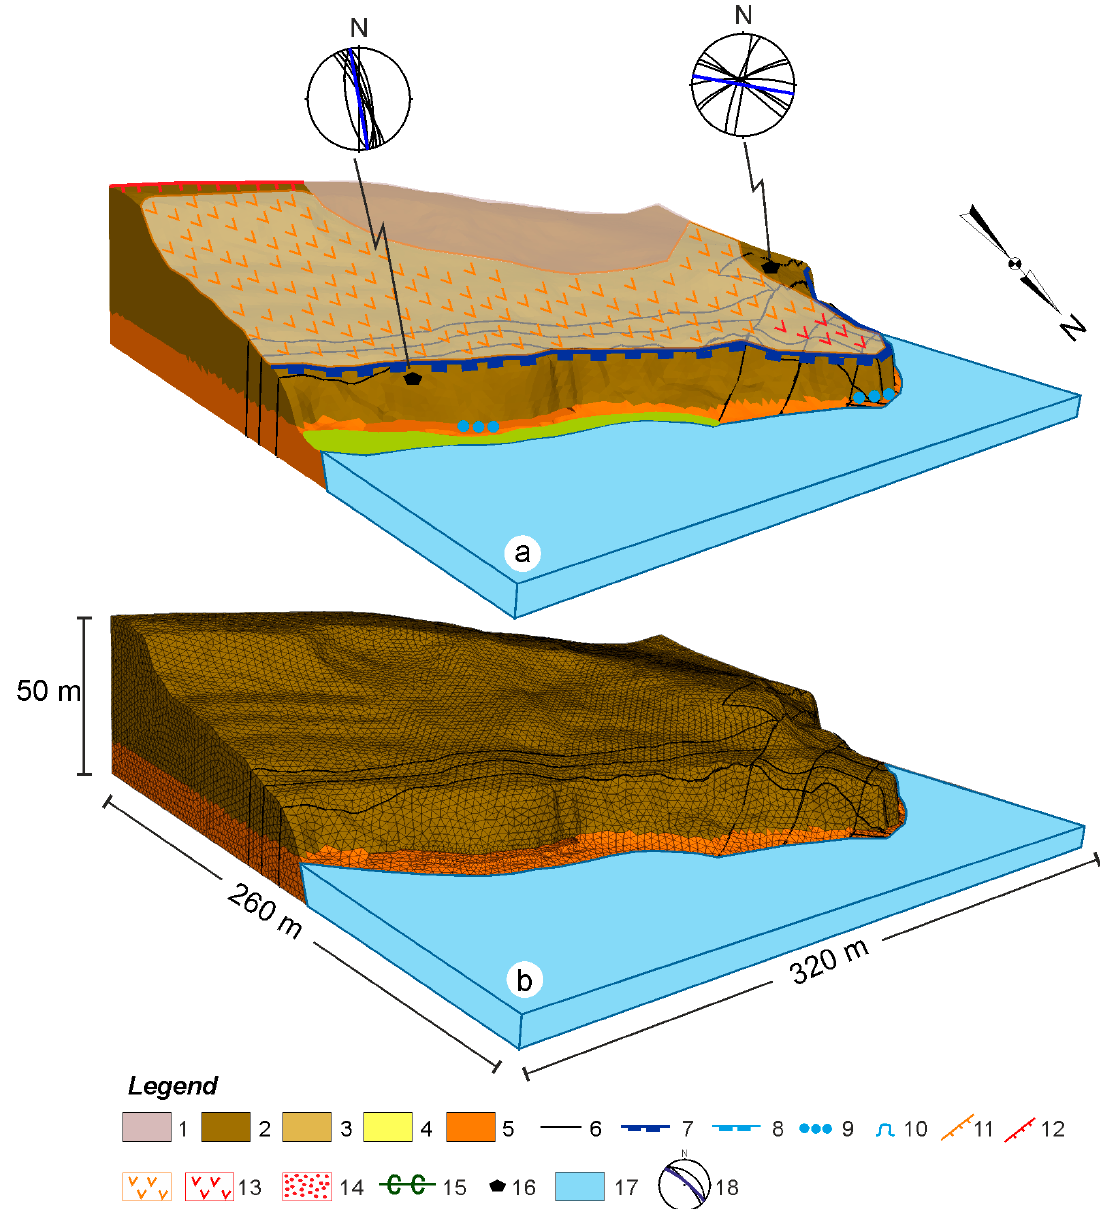
Figure 12. ( a ) The geological and geomorphological model of the Punta Ferruccio cliff; and ( b ) the simplified model for the numerical modelling (removing superficial deposits < 3 m in thickness).